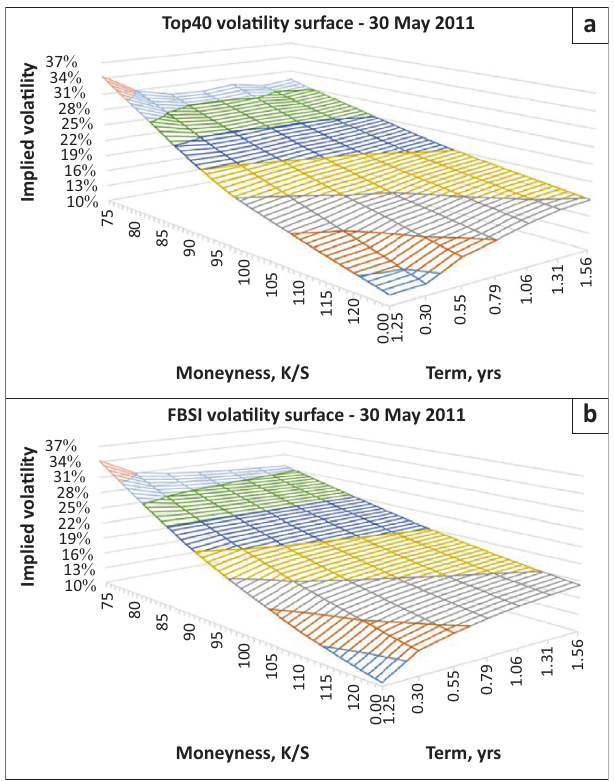
FIGURE 5: (a) Top40 and calibrated, and (b) FBSI implied volatility surface as at 30 May